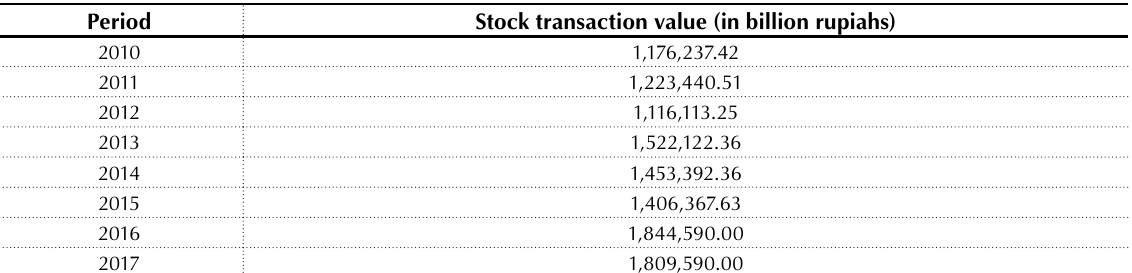
Source: The Indonesia Financial Service